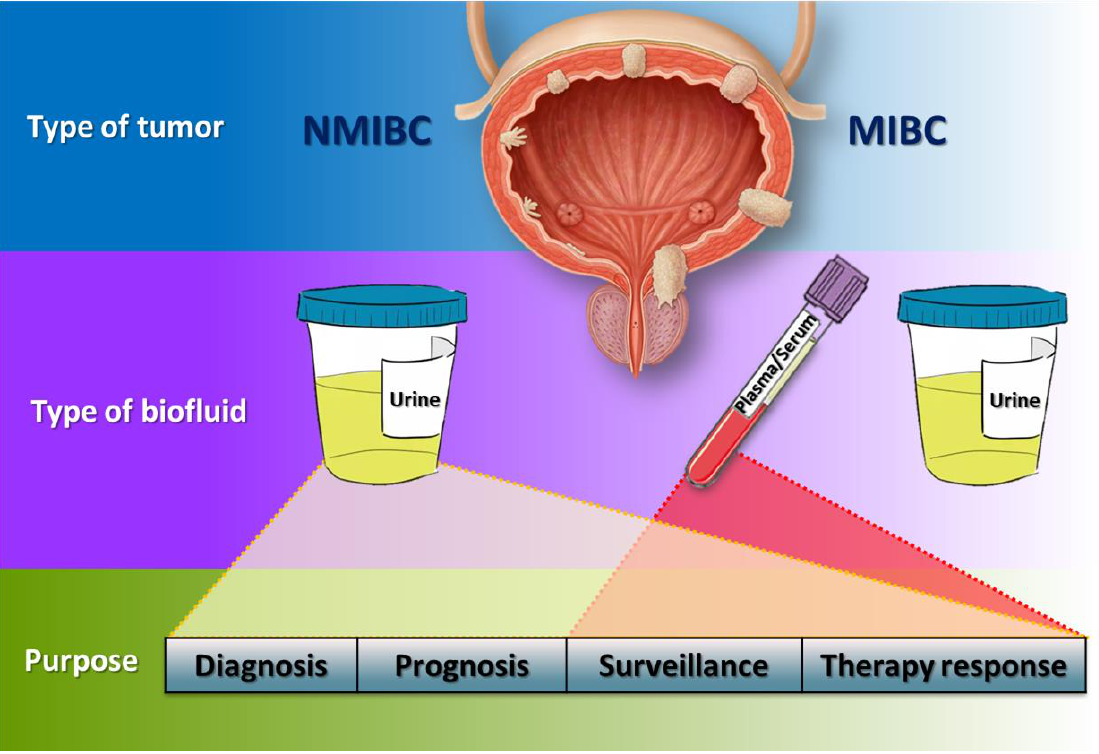
Figure 3. Hypothetical flowchart of liquid biopsies management in BC. In NMIBC patients, urine could be the best type of biofluid for diagnosis, prognosis, surveillance and therapy response due to its intimate contact with the tumour, whilst in MIBC patients, though urine could also be used, plasma and serum acquire more importance to monitor patients.